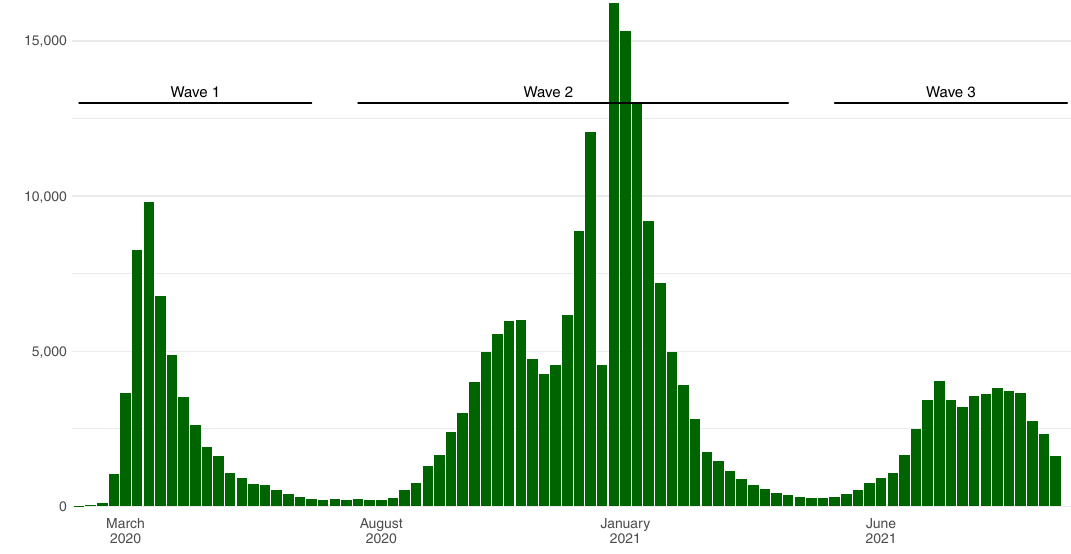
Fig.1|ObservednumberofindividualshospitalisedwithCOVID-19,byweekofadmission. March2020toSeptember2021.Annotationsshownforwave1,wave2,and wave 3. n =259,727 individuals.